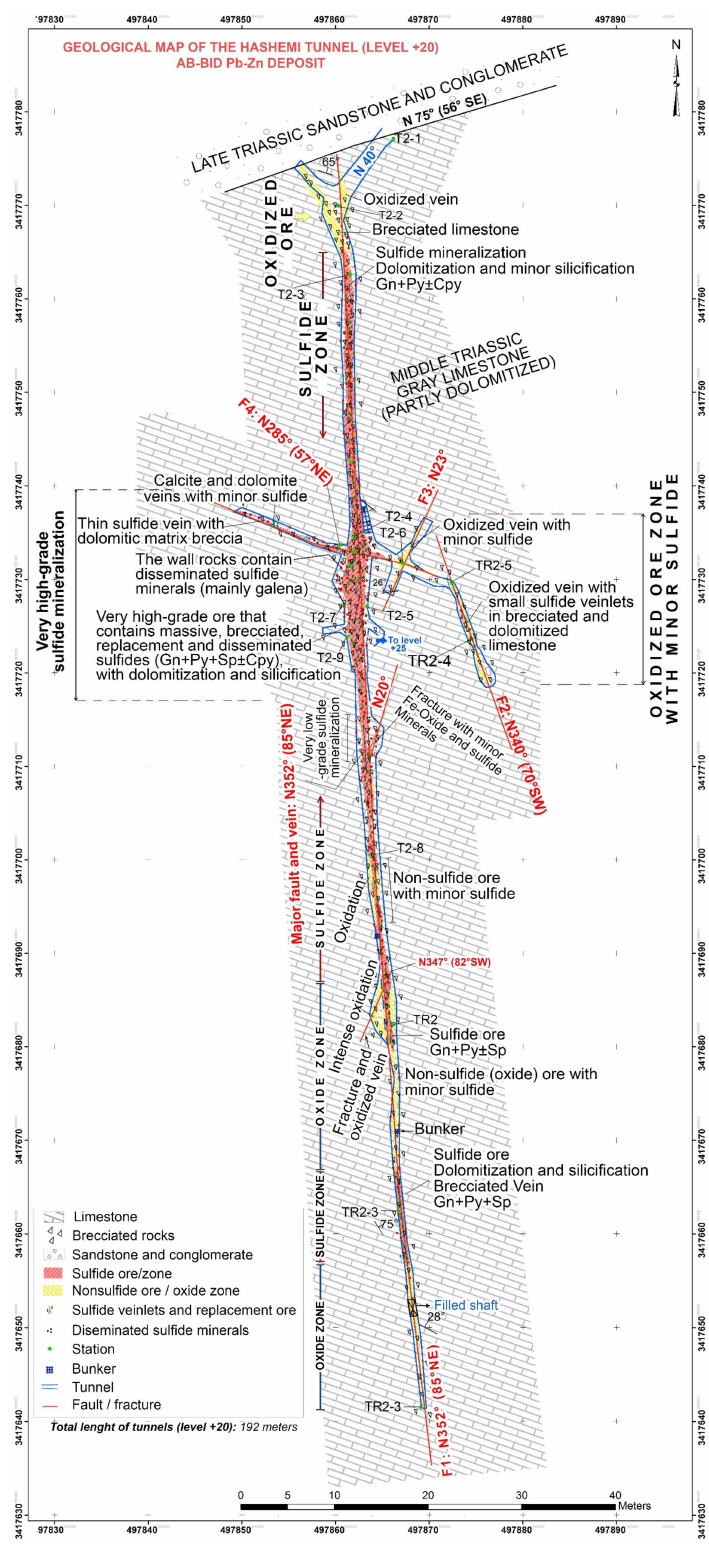
Figure 7. Geological map of the New Mine (Hashemi) tunnel, +20 mining level